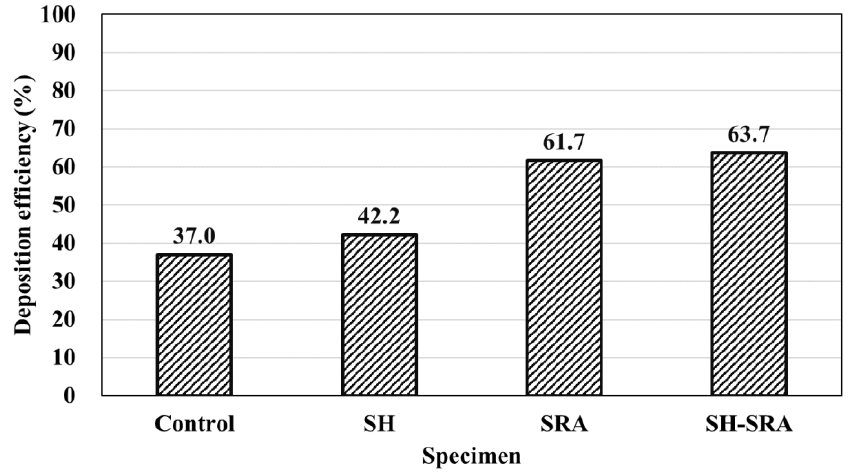
Figure 7. Deposition efficiency of metal spray coating according to surface treatment conditions.